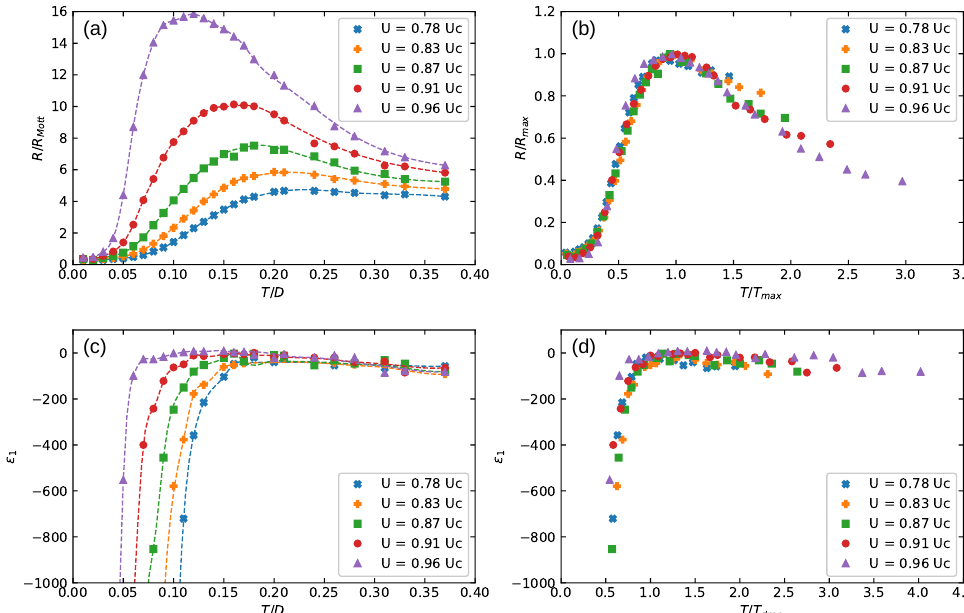
Figure 10. ( a ) DC resistivity as a function of temperature for several interaction strengths. ( b ) Scaled resistivity curves. ( c ) Real part of dielectric function (cid:101) 1 at ω / D = 0.01, as a function of temperature for several interaction strengths. ( d ) Scaled dielectric function curves. Results are obtained for a half-filled Hubbard model solved within DMFT.